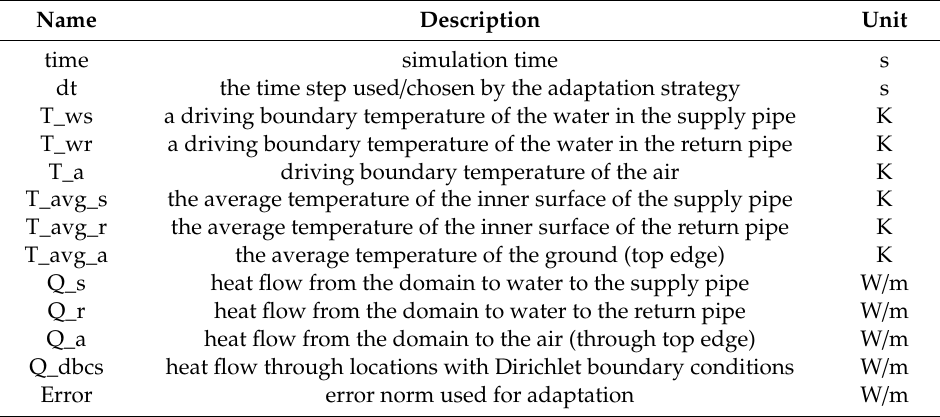
Table 1. Data recorder during the complex simulation.